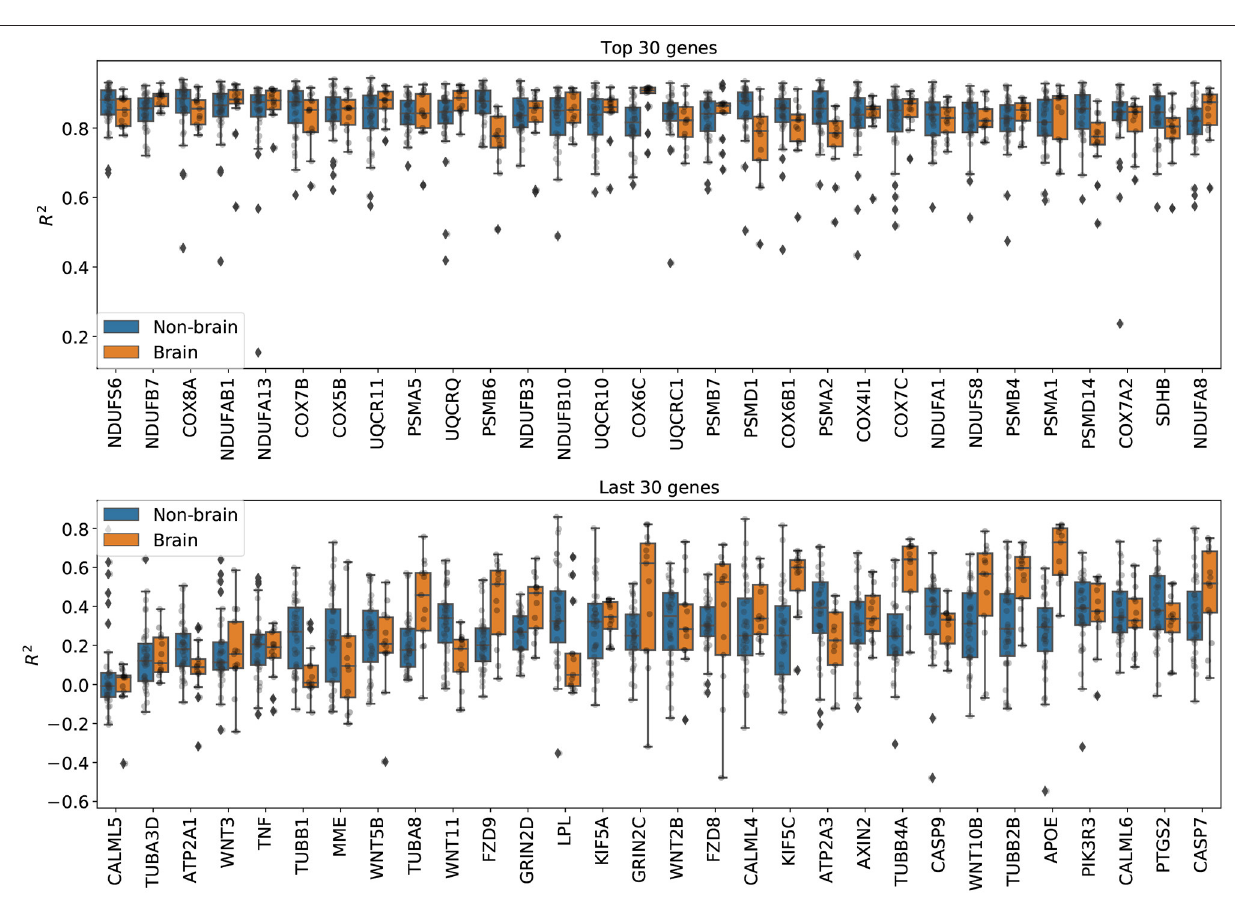
FIGURE 5 | Per-gene imputation R 2 scores on genes from the Alzheimer’s disease pathway. Each point represents the average R 2 score in a tissue type. We note that some genes in the pathway (e.g., PSMB6, COX6C, PSMD7, PSMA2, PSMD14, SDHB, TUBB1, TUBA8, FZD9, LPL, KIF5C, TUBB4A, TUBB2B, APOE) exhibited different distributions between brain and non-brain tissue